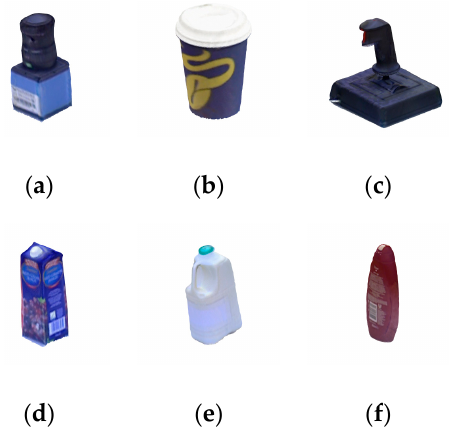
Figure 8. Six objects in the Tejani dataset: ( a ) Camera; ( b ) Coffee Cup; ( c ) Joystick; ( d ) Juice Carton; ( e ) Milk; ( f ) Shampoo.